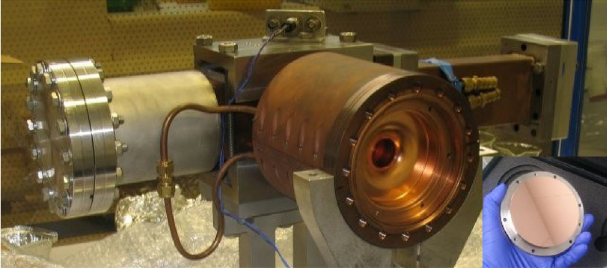
2.5FIG. 12. The 2.5-cell photoinjector cavity before installation. Inset: The diamond turned copper photocathode used during operation at simulated distribution of the electric field are shown in Fig. 11; a picture of the photoinjector is shown in Fig. 12.